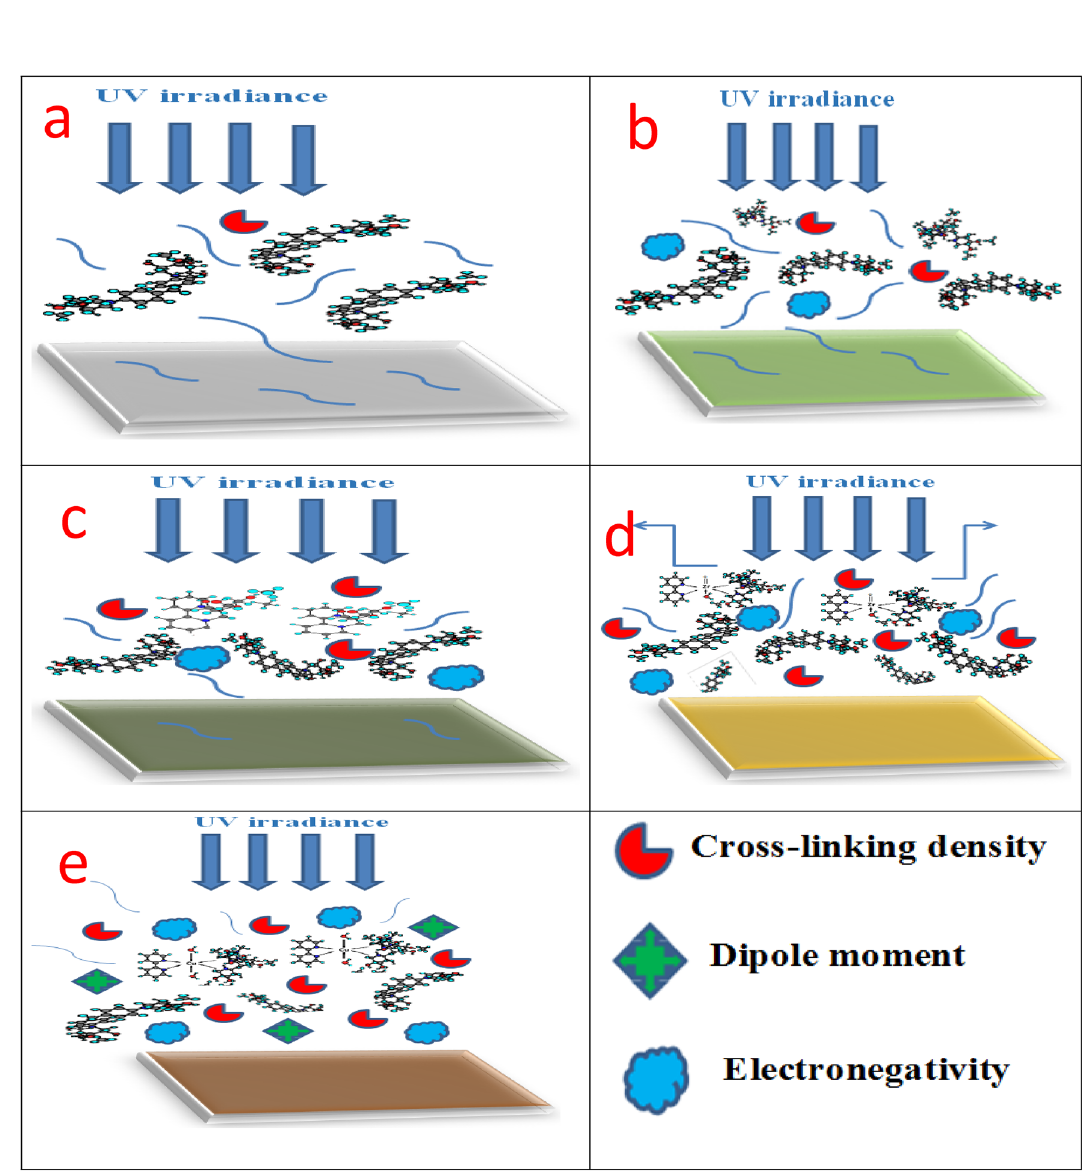
Figure 15. The expected UV resistance mechanisms of the investigated coated films ( a ) Unmodified conventional epoxy, ( b ) PA-DGEBA/MF, ( c ) PA-DGEBA/Bipy, ( d ) PA-DGEBA/MC-Zr and ( e ) PA-DGEBA/ MC-Cu after the direct exposure to solar box UV irradiance for 80